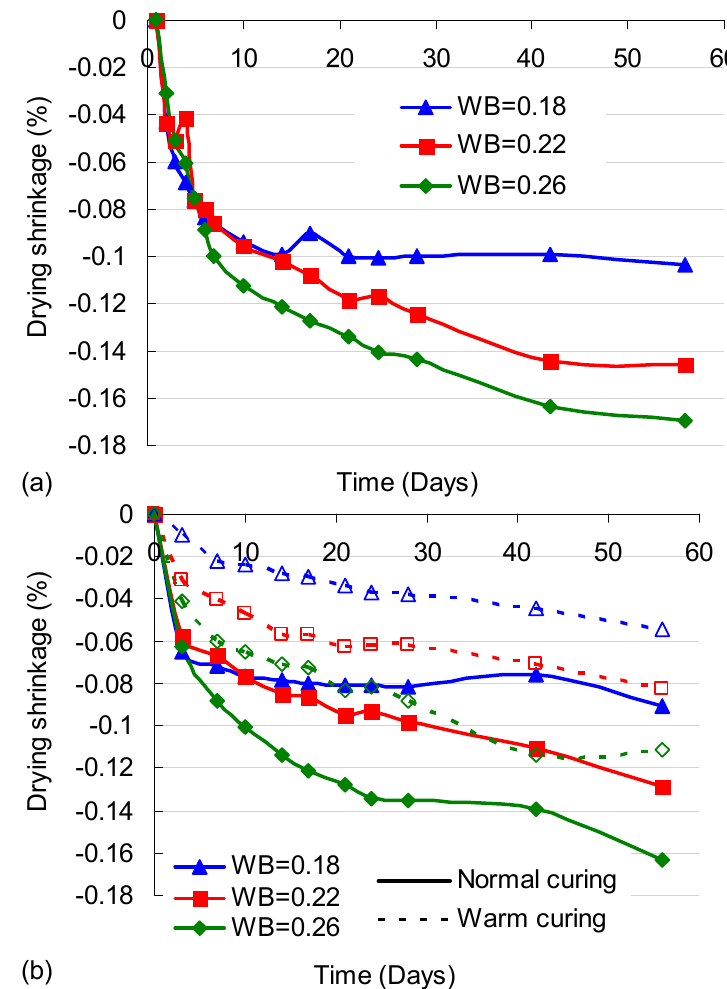
Figure 12. Effect of the WB on drying shrinkage of RPC: ( a ) one-day air curing; ( b ) seven-day moist curing.